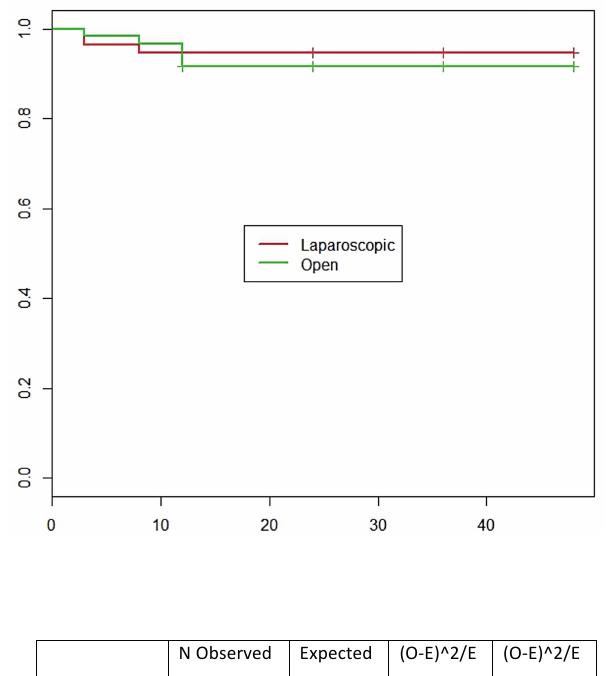
figure 1 - Estimated mean time for BC failure in laparoscopic versus open